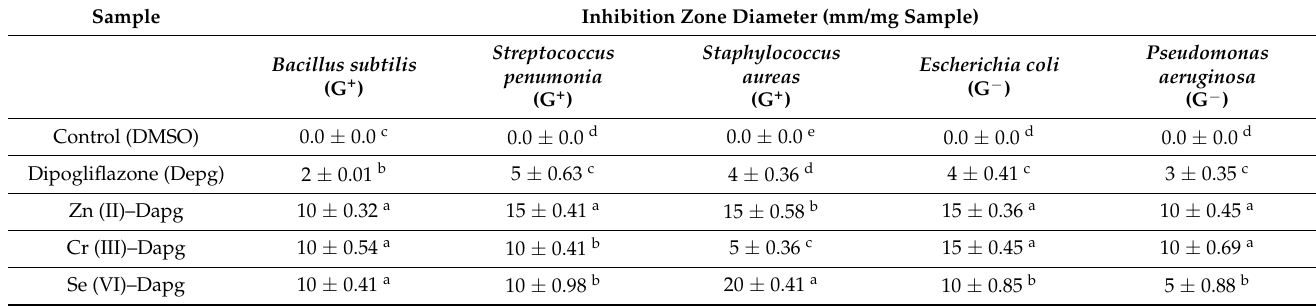
Figure 6. Antibacterial activity of Dapg and Zn (II)–, Cr (III)– and Se (IV)–Dapg metal complexes. Table 1. Inhibition zone diameter (mm/mg sample) of Dipogliflazone and the